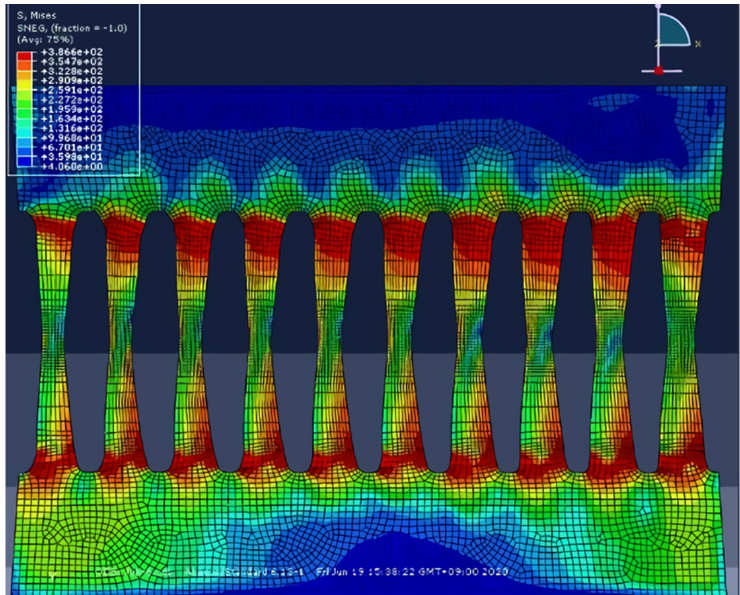
Figure 9. Von-Mises stress distribution for steel shear panel damper. Based on the normalized maximum PEEQ results (obtained from values associated with the optimal solution), behavioral comparisons are performed. Table 1 shows the results of the dissipated energy and optimization function. The buckling resistance models exhibit effective energy dissipation due to the occurrence of both shear and flexure yielding limit states simultaneously allowing uniform plastic strains and stresses distribution. Table 1. Sample of the results for optimization study on the steel shear damper.